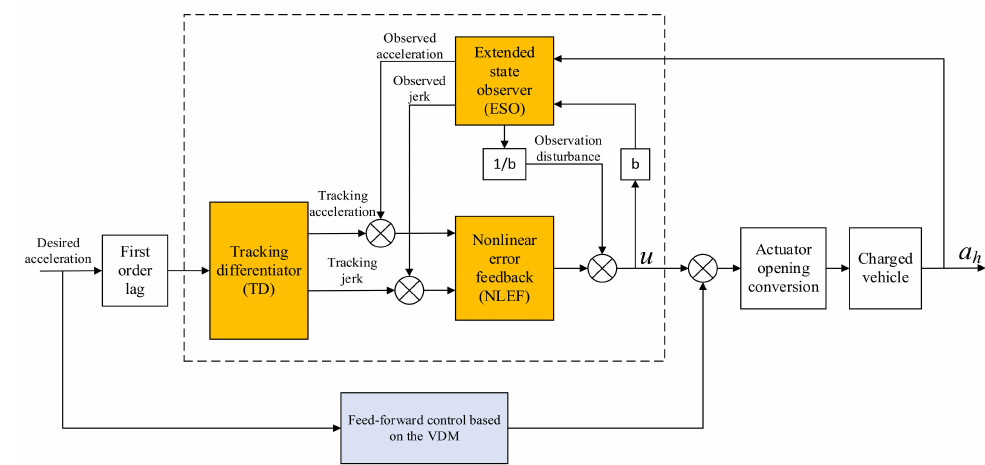
Figure 2. Principle of the lower-level